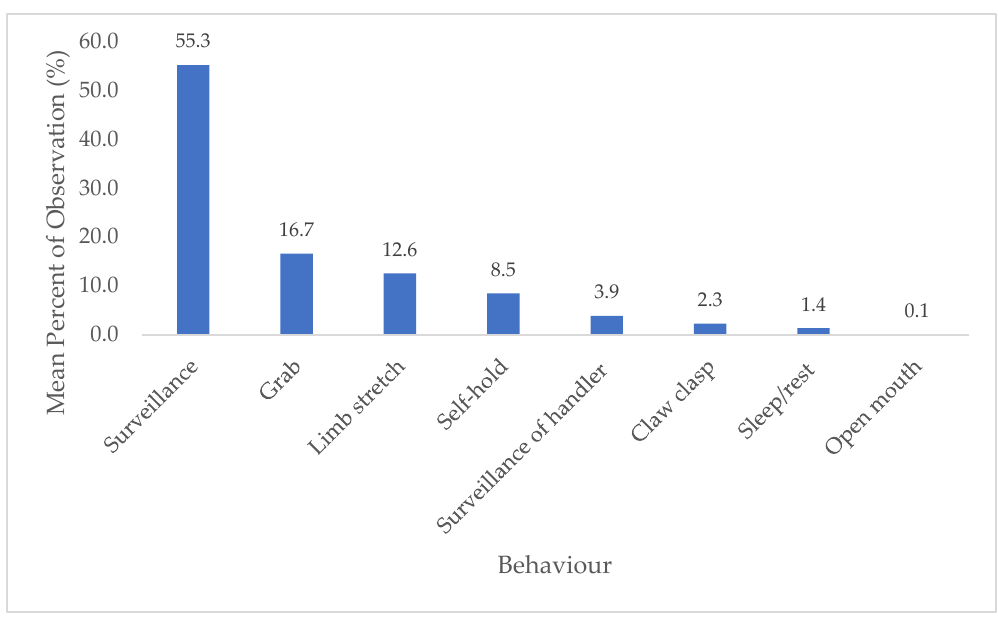
Figure 2. Mean percentage of time the sloths spent engaged in each behaviour.